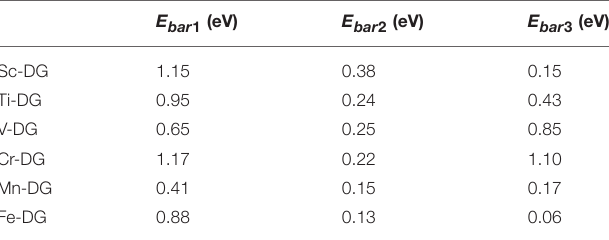
TABLE 1 | The reaction energy barriers of each step for the CO oxidation on divacancy graphene decorated with transition metal (from Sc to Fe) along the LH mechanism, where E bar1 , E bar2 , and E bar3 are the energy barriers for step 1, step 2, and step 3 during CO oxidation, respectively.